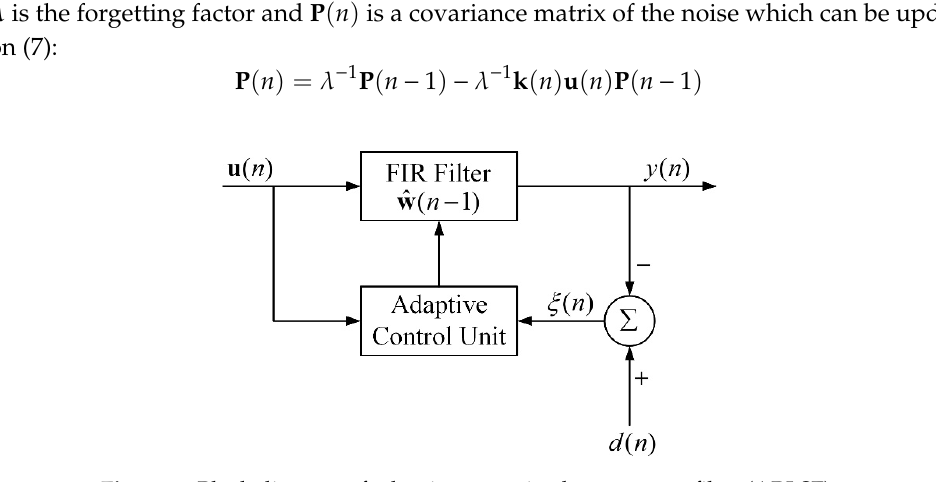
Figure 1. Block diagram of adaptive recursive least squares filter (ARLSF).